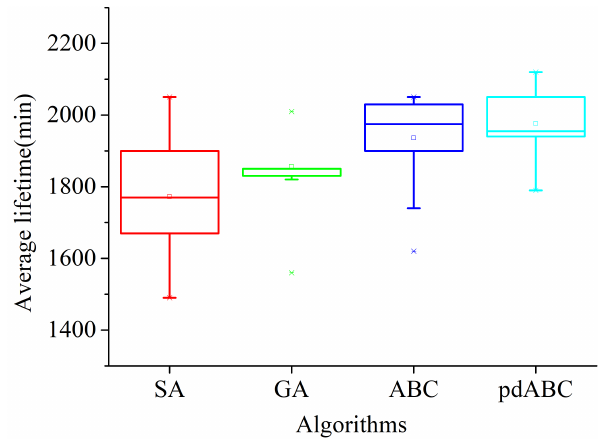
Figure 11. Optimal lifetime distribution box plot with six RNs in 100 × 100 terrain.